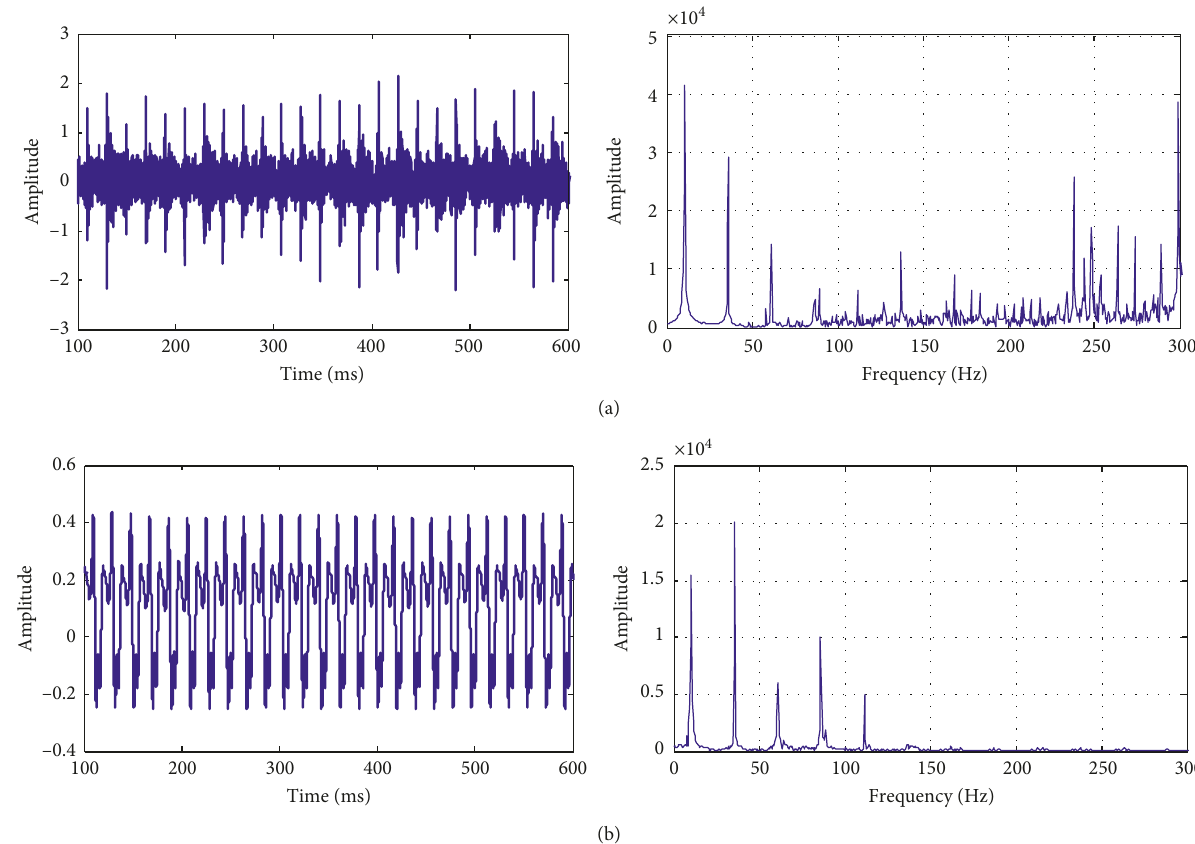
Figure 18: Vertical vibration amplitude signals and their frequency diagram on bearing with pedestal looseness coupled with rub-impact (looseness clearance 0.0002m). (a) Vibration amplitude signals and its frequency diagram. (b) Denosing vibration amplitude signals and (cid:31) its frequency